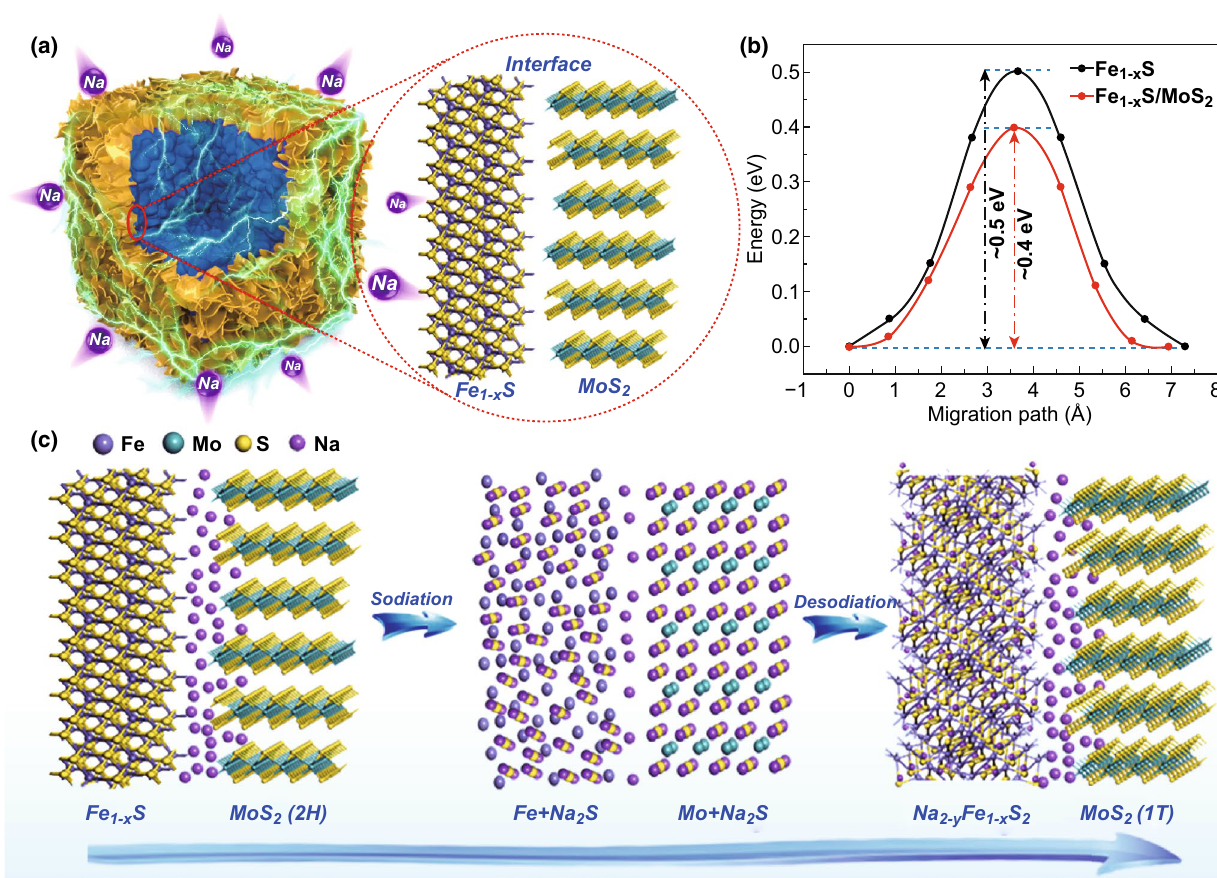
Fig. 5 a Schematic illustration of Fe 1− x S/MoS 2 interface. b The diffusion barrier profiles of Na on Fe 1− x S surface and Fe 1− x S/MoS 2 interface. c Proposed schematic atomistic models of the illustrated reaction mechanism for Fe 1− x S/MoS 2 heterostructure during the sodiation and desodia- tion